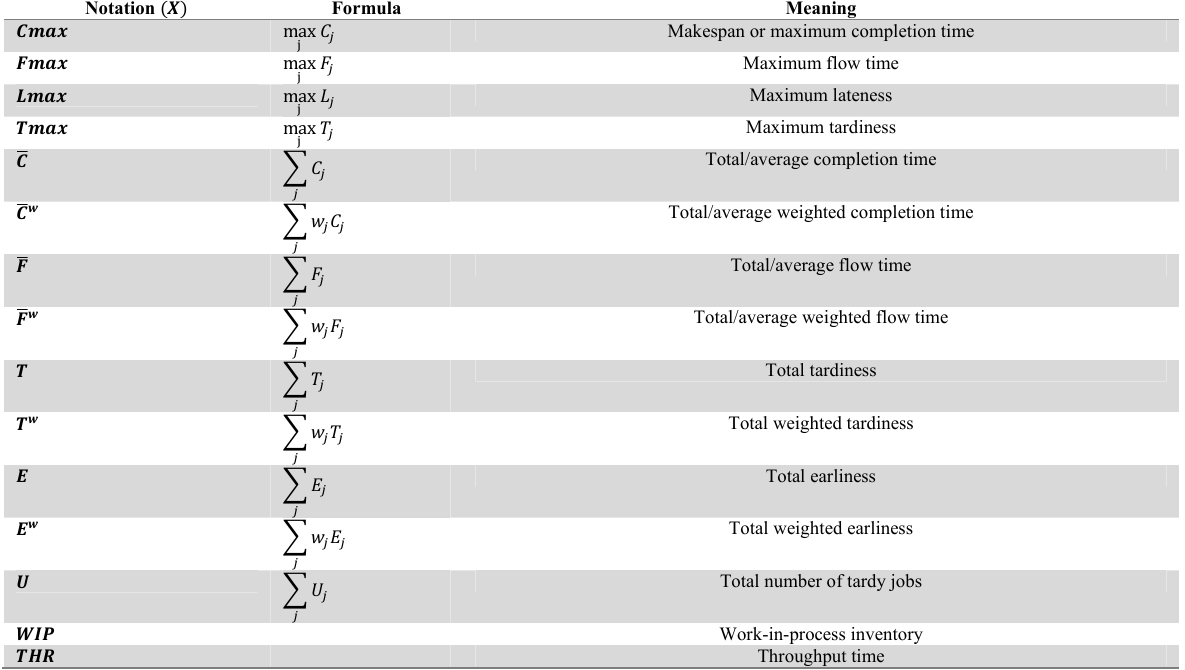
Objective functions in deterministic